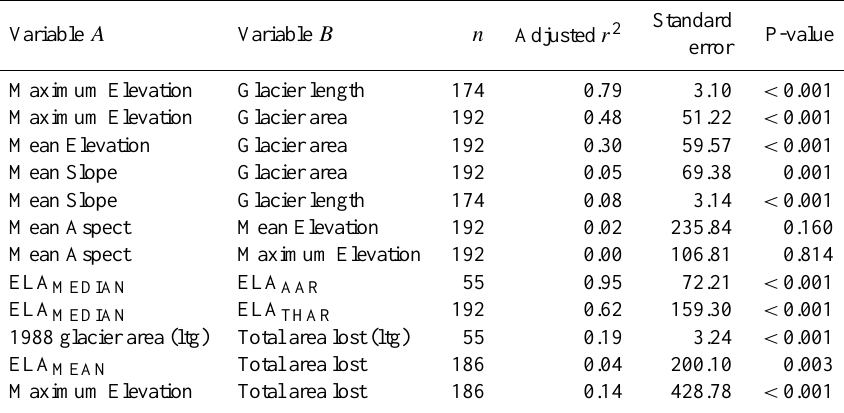
Table 5. Regression table for variables in the inventory. n is the number of observations. “ltg” means “land-terminating glacier”. P-values are calculated at the 95% confidence level.